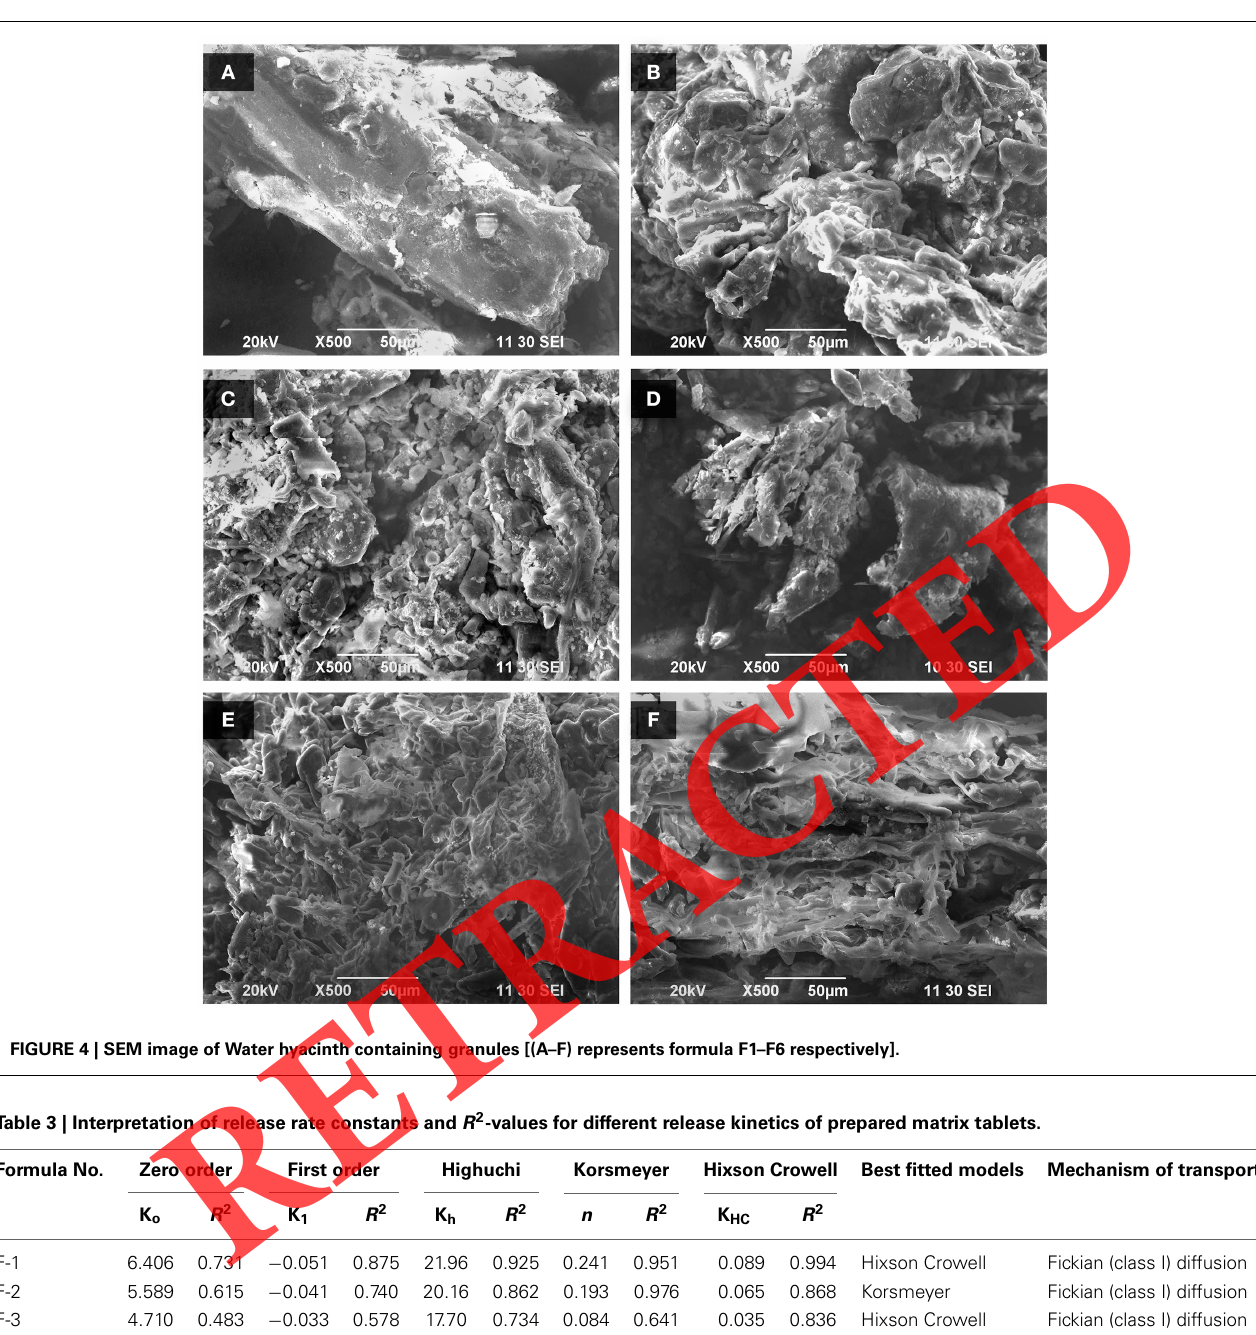
Table 3 | Interpretation of release rate constants and R 2 -values for different release kinetics of prepared matrix tablets. Formula